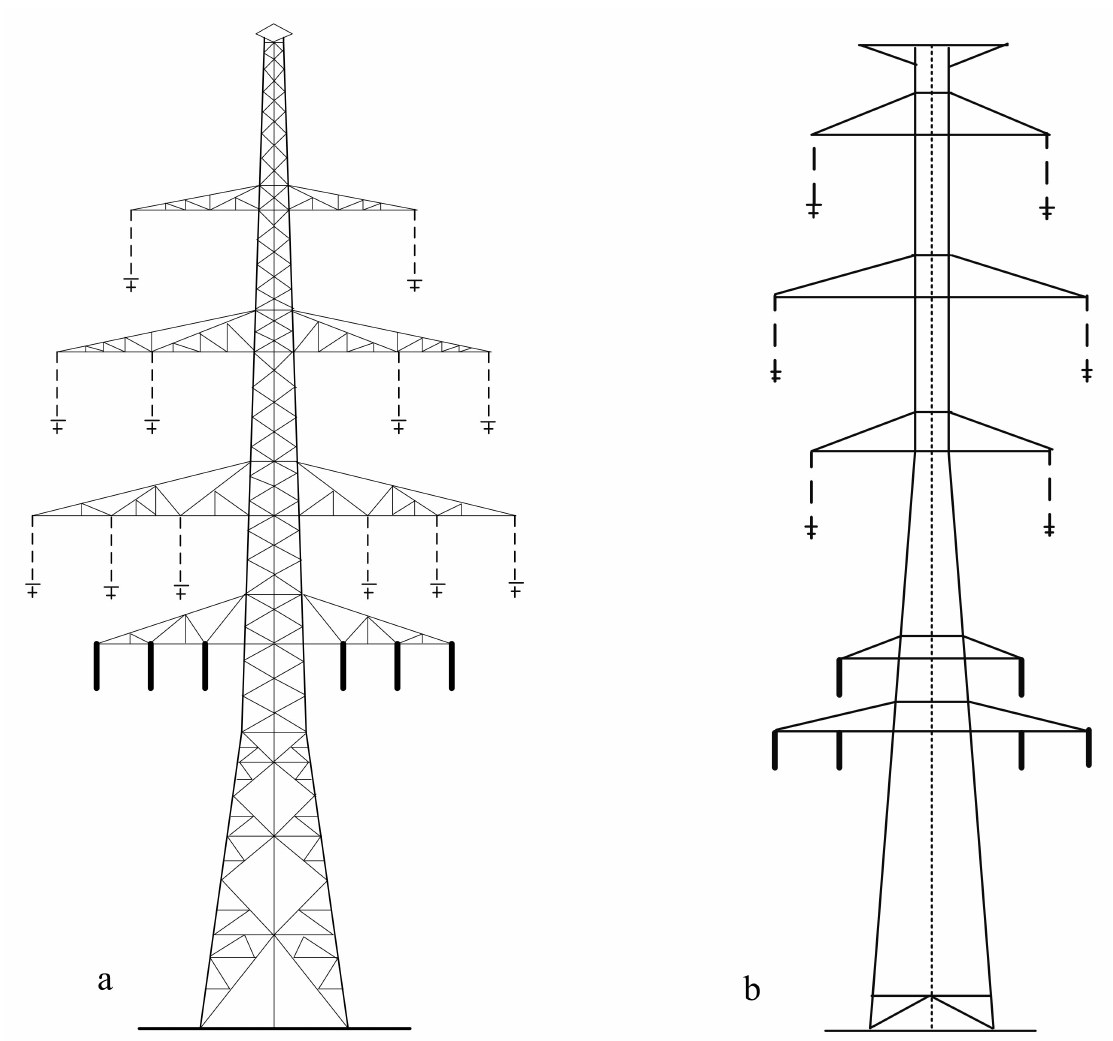
Figure 1. Design of transmission towers of ( a ) a six-circuit 2 × 380 kV + 2 × 220 kV + 2 × 110 kV MCTL and ( b ) a four-circuit 2 × 400 kV + 2 × 110 kV